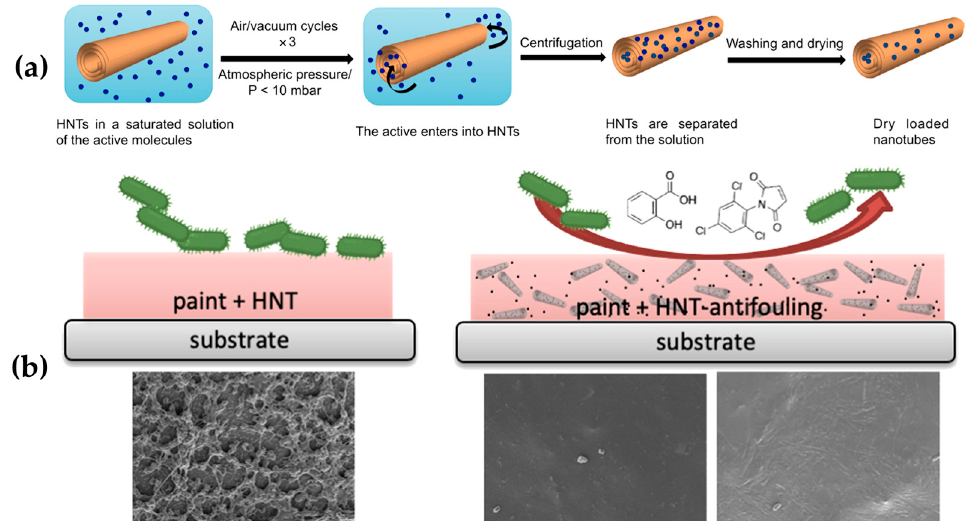
Figure 23. Schematic preparation of the eco-friendly sodium salicylate and N-(2,4,6-trichlorophenyl)maleimide biocide agent-loaded HNTs ( a ) and antifouling behavior of the hybrid composite epoxy-based paint obtained from the incorporation of the functional HNTs ( b ). Reprinted with permission from Ref. [77]. Copyright 2021, M. Tonelli, Colloids and Surfaces A: Physicochemical and Engineering Aspects,